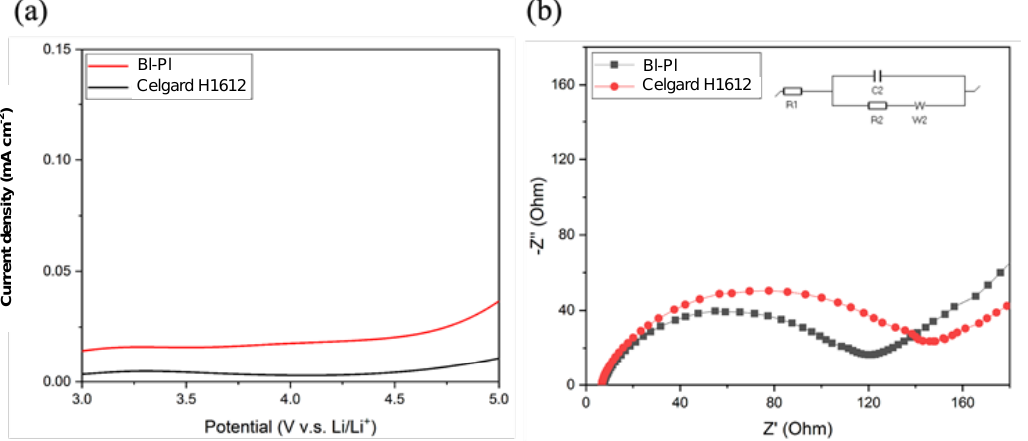
Figure 7. ( a ) LSV curves of Li/Separator/SS measured at a rate of 10 mV s −1 in the range of 3 V to 5 V ( b ) Nyquist plots obtained under Li/Separator/Li system. 5 V ( b ) Nyquist plots obtained under Li/Separator/Li